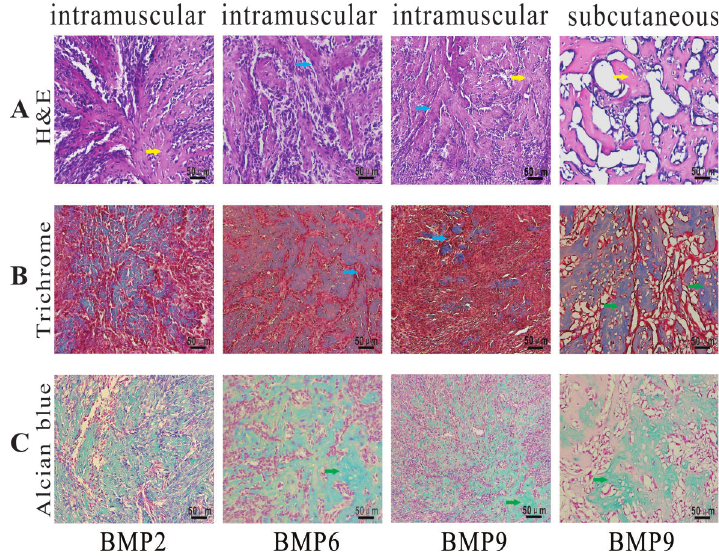
Figure 6. Sections of the bone morphogenetic proteins (BMPs)-treated samples were retrieved, fi xed, decalci fi ed, and subjected to paraf fi n-embedded sectioning for histologic evaluation. Bone-like trabeculae (blue arrows) and osteoid matrix (yellow arrows) were observed by hematoxylin and eosin (H&E) staining ( A ). Mineralized osteoid matrix (blue arrows) and cartilage-like tissues (green arrows) were observed by trichrome staining ( B ). Cartilage-like deposits were observed by alcian blue staining ( C ). Scale bars 50 m